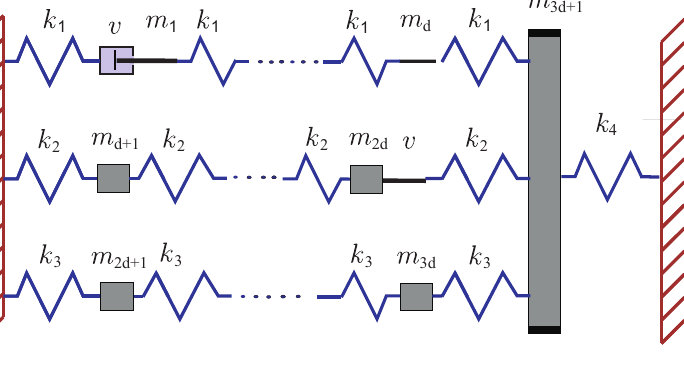
Figure 2. 3 d + 1 mass